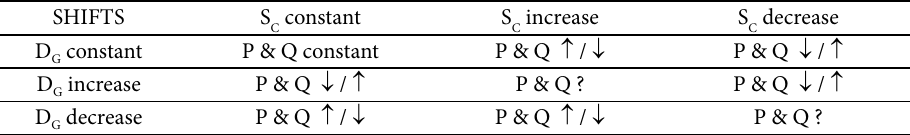
Table 4.1. Simultaneous shifts (Increases) of Giffen demand and classical supply in the same direction Magnitude of shift Giffen demand and classical supply increase both more elastic than S D less elastic than S D G C G C S > D Situation 1: P? and Q ↑ Situation 2: P ↓ and Q? C G (larger shift in classical supply)